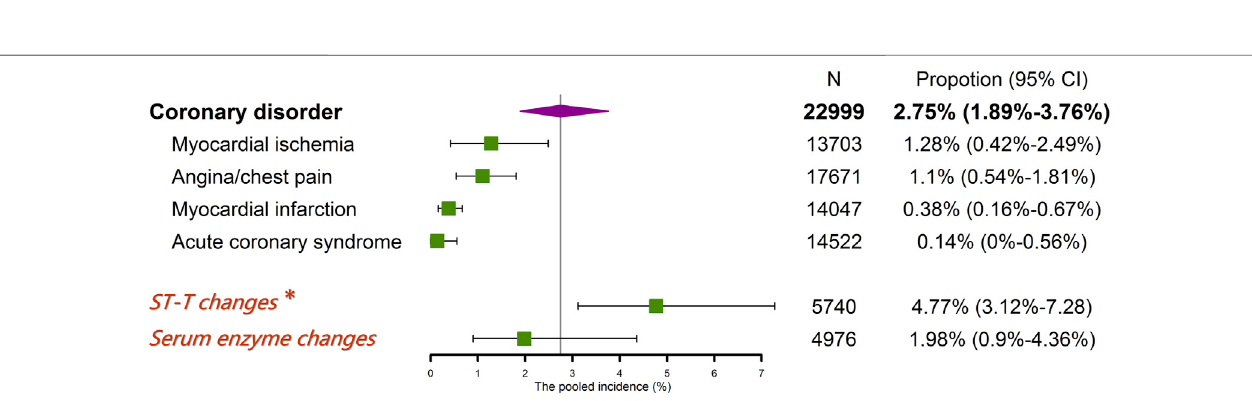
FIGURE 3 | The pooled incidence of speci fi c reported events of coronary disorders. * a pooled incidence of 4.77% (95% CI 3.12% – 7.28%), containing ST-T changes on ECG with or without symptomatic coronary toxicities.